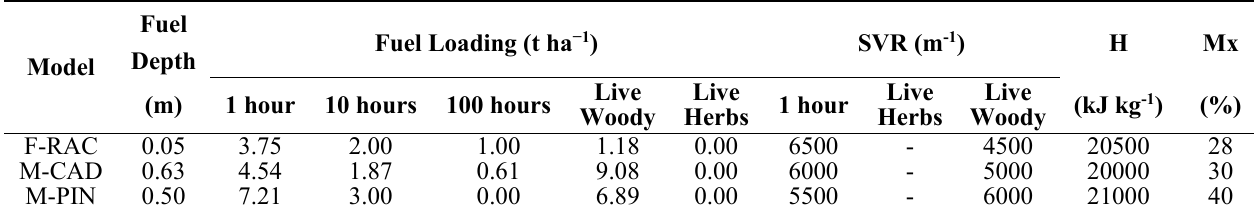
Table A1. Fuel model parameters; SVR = surface-area-to-volume ratio; H = heat content; Mx = 1-hour fuel moisture content of